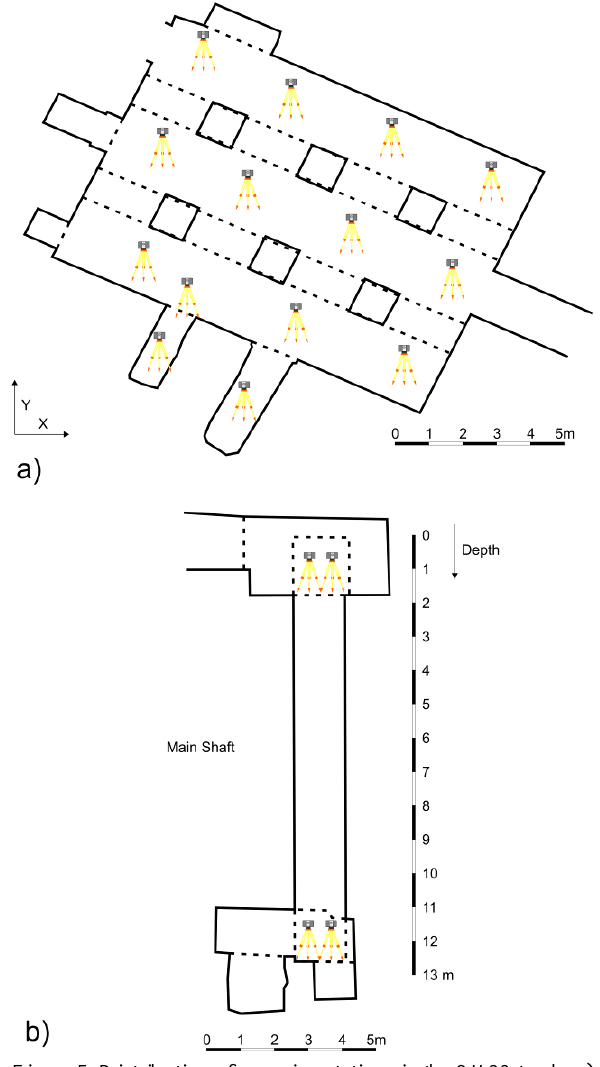
Figure 5. Distribution of scanning stations in the QH33 tomb: a) top view of the Hypostyle hall; b) side view of the main shaft.